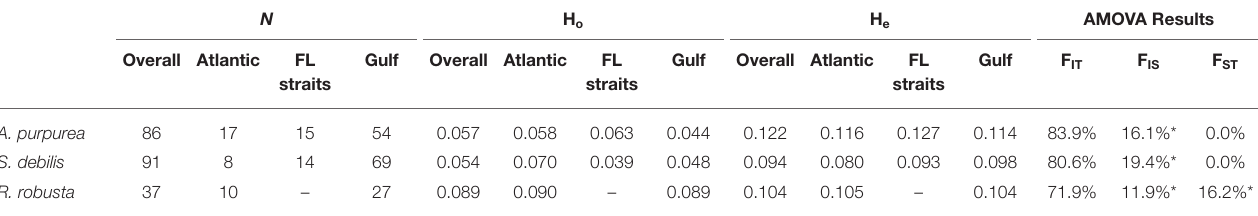
TABLE 1 | Sample sizes and diversity indices, including observed heterozygosity (Ho) and expected heterozygosity (He), for the three targeted species: Acanthephyra purpurea, Systellaspis debilis , and Robustosergia robusta . N H o H e AMOVA Results Overall Atlantic FL Gulf Overall Atlantic FL Gulf Overall straits straits